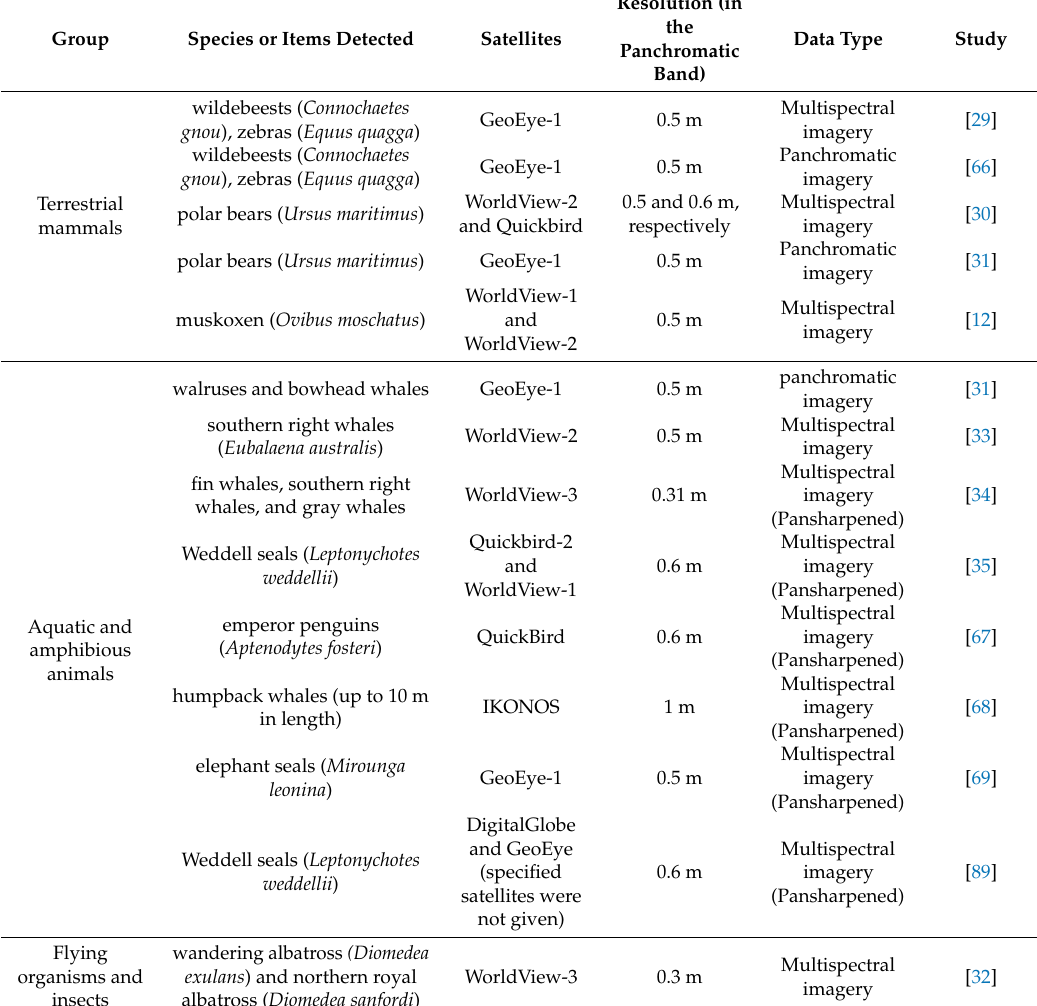
Table 3. Animal species detected using spaceborne